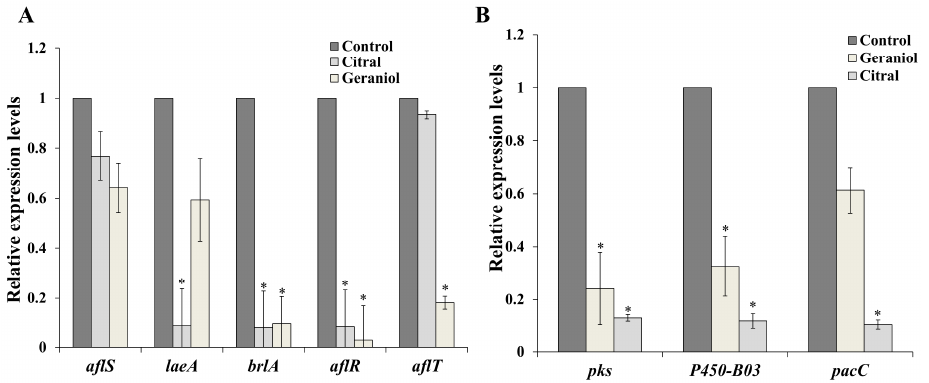
Figure 5. Relative mRNA expression of growth- and secondary metabolism-related genes of Aspergillus spp. after treatment with geraniol and citral, by qRT-PCR. ( A ) Expression analysis of growth and aflatoxin biosynthetic genes in A. flavus ; ( B ) Expression analysis of growth and ochratoxin biosynthetic genes in A. ochraceus. Values represent fold changes on the basis of the control (set as 1). Columns with an asterisk ( p < 0.05) at the same gene were considered differentially expressed if the corresponding fold change was ≥ 2 or ≤